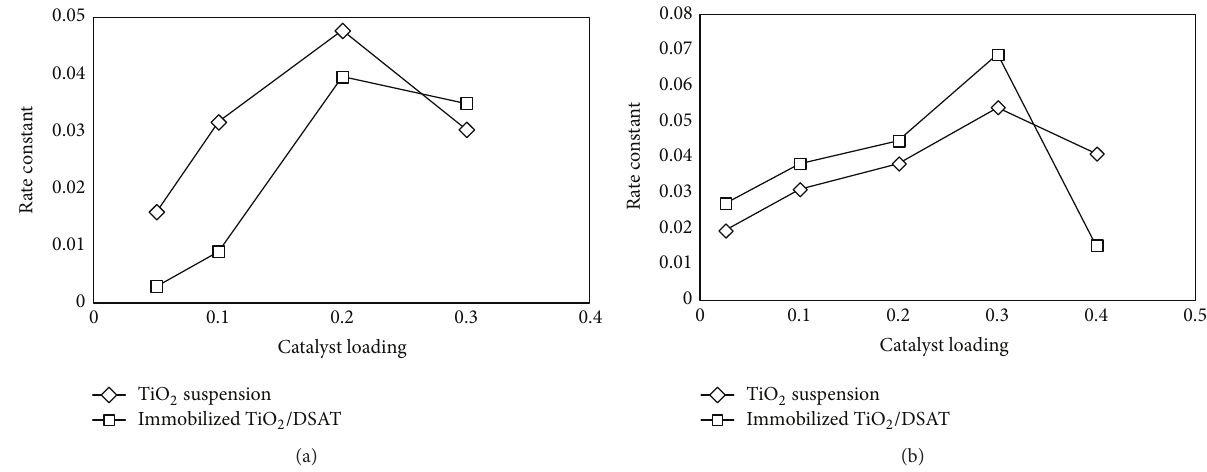
Figure 1: Photocatalytic degradation rate of immobilized TiO 2 /DSAT and suspension TiO 2 under (a) RR4 removal and (b) MB removal.